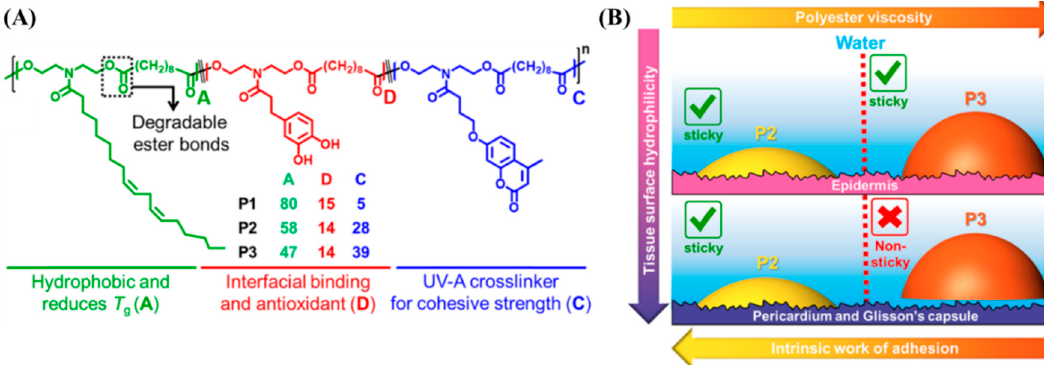
Figure 6. ( A ) Schematic representation and chemical composition of the soybean oil-derived photocrosslinkable polyester adhesives and ( B ) the origin of the tissue-specific adhesion observed in the polyesters. The polyester with a higher viscosity (P3) does not adhere to tissue surfaces with higher water content such as the heart and liver [97]. Copyright 2019, reproduced with permission from the American Chemical Society.